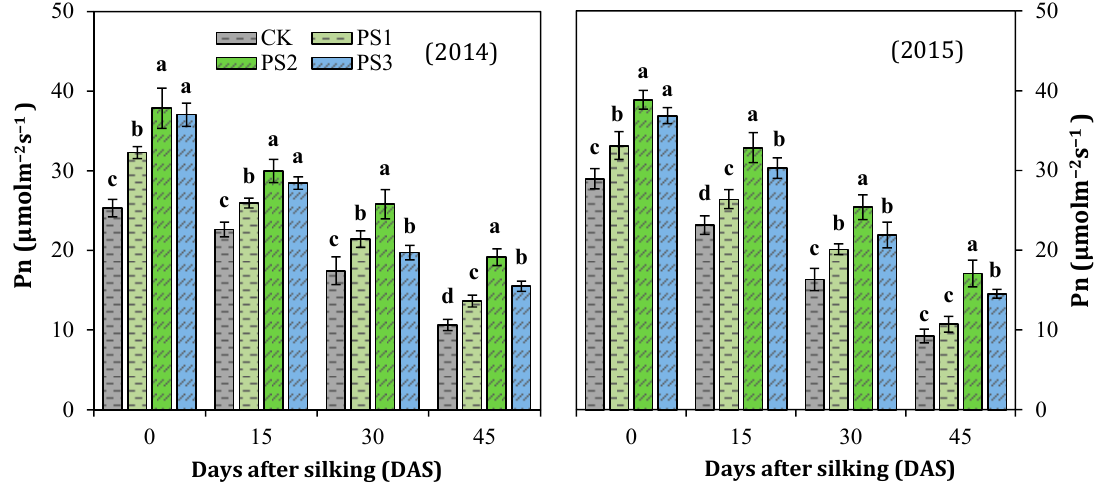
Figure 4. Effects of paclobutrazol treatments on net photosynthesis rate of maize during 2014 and 2015. Data are presented as mean ± SD of three measurements. Different small letters on the bars indicate significant differences at P < 0.05 (LSD test). The abbreviations of treatment names are the same as those described in Figure 2.